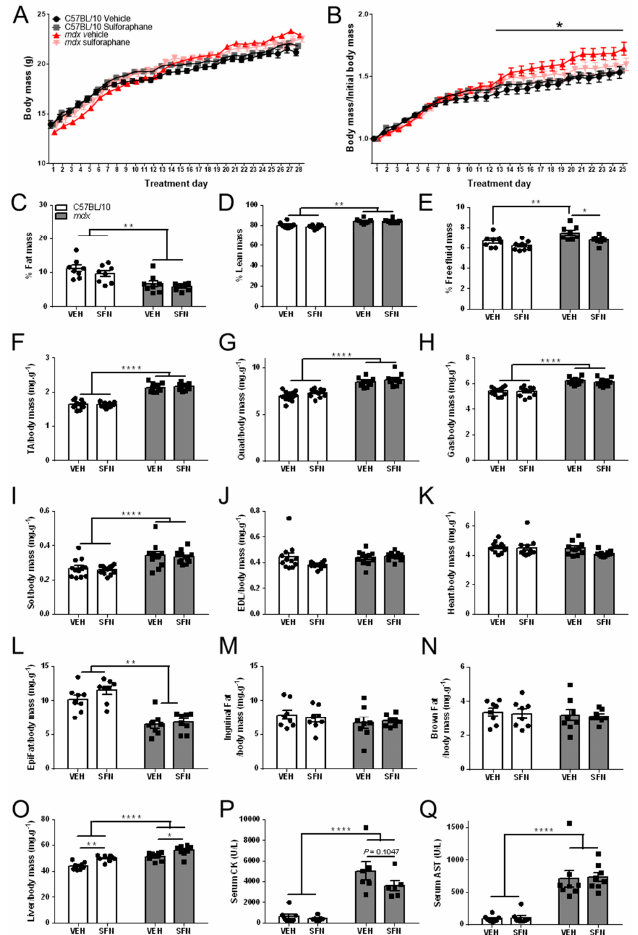
Figure 3. Oral SFN administration does not alter muscle or organ mass in mdx mice. Four-week-old male C57BL/10 and mdx mice received either vehicle (2% DMSO/corn oil; VEH) or SFN (2 mg/kg in 2% DMSO/corn oil; SFN) via daily oral gavage for five days a week for four weeks. Body mass ( A ) was measured daily over the treatment period and assessed relative to starting body mass ( B ). Statistical analysis was performed using a repeated measures two-way ANOVA with a Bonferroni’s post-hoc test to assess the effects of treatment. n = 20/group. Body composition was analysed prior to dissection to measure the % fat mass ( C ), % lean mass ( D ) and % free fluid mass ( E ) of all mice. Statistical analysis was performed using a two-way ANOVA with a Bonferroni’s post-hoc test to assess effects of treatment. n = 8/group. Mass of the tibialis anterior (TA; ( F )), quadriceps (Quad; ( G )), gastrocnemius (Gas; ( H )), soleus (sol; ( I )), extensor digitorum longus (EDL; ( J )) muscles as well as the heart ( K ), epididymal fat ( L ), inguinal fat ( M ), brown fat ( N ), and liver ( O ) masses relative to body mass were determined at endpoint. n = 10–12/group. Serum levels of CK ( P ) and AST ( Q ). n = 6–8/group. * p < 0.05, ** p < 0.01, **** p <